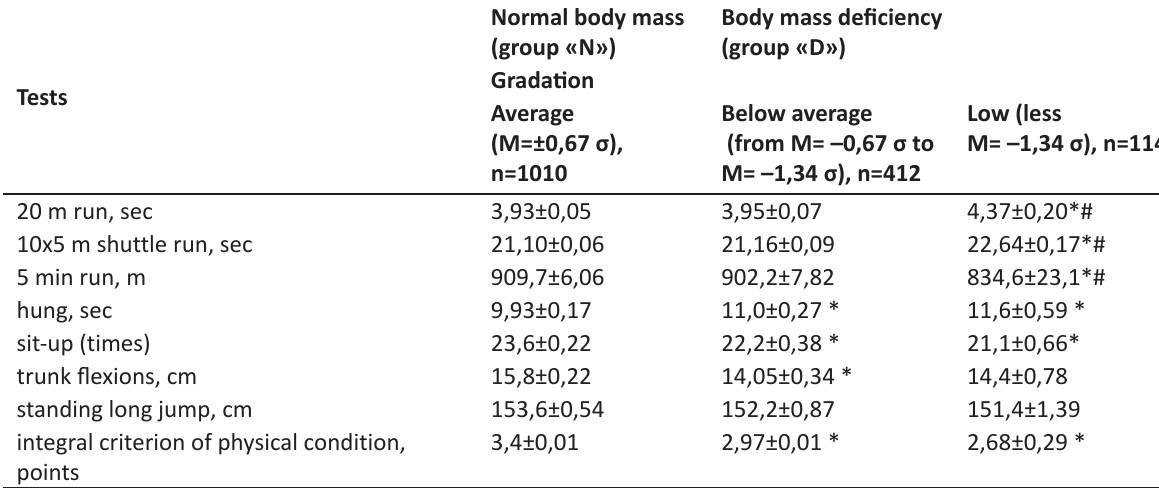
Table 2. Results of motor tests (М±m) of females with different gradation of body mass parameter